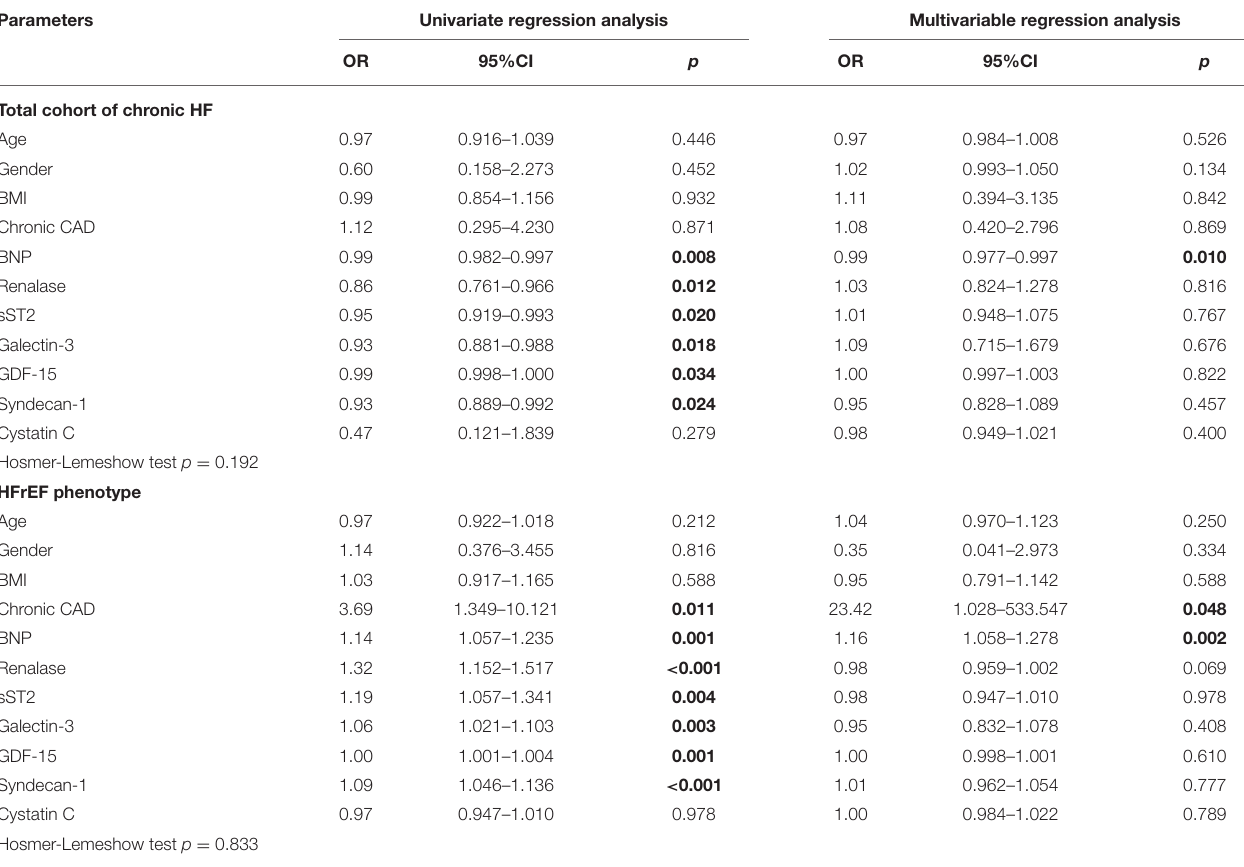
TABLE 3 | Univariate and multivariable regression analyses of renalase, BNP, cystatin C and biomarkers of myocardial remodeling for prediction of ischemia in the chronic HF patients.